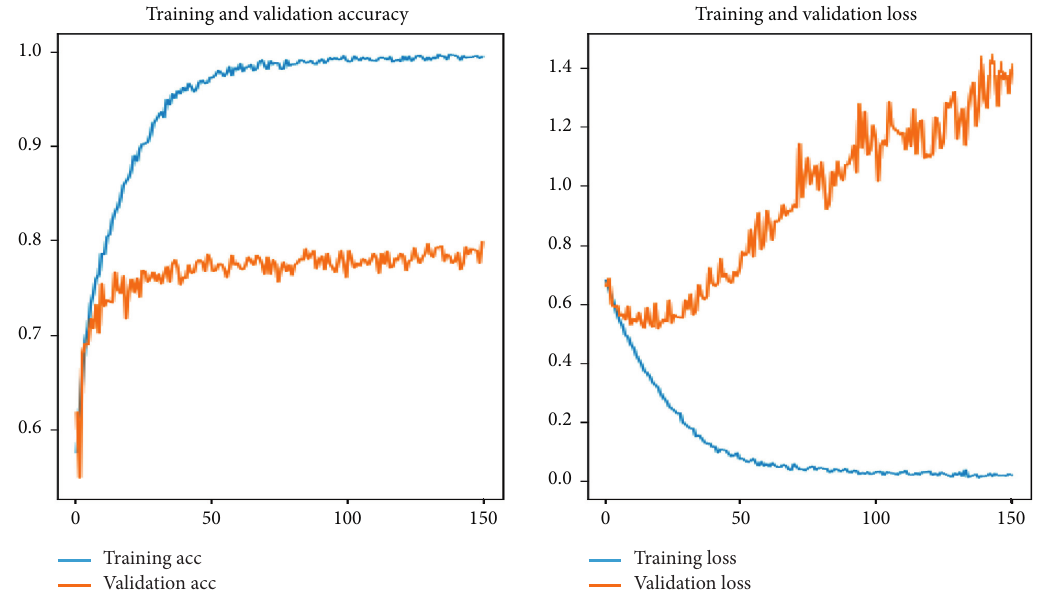
Figure 5: Overfitting. (a) Accuracy curve after dropout. (b) Loss curve after